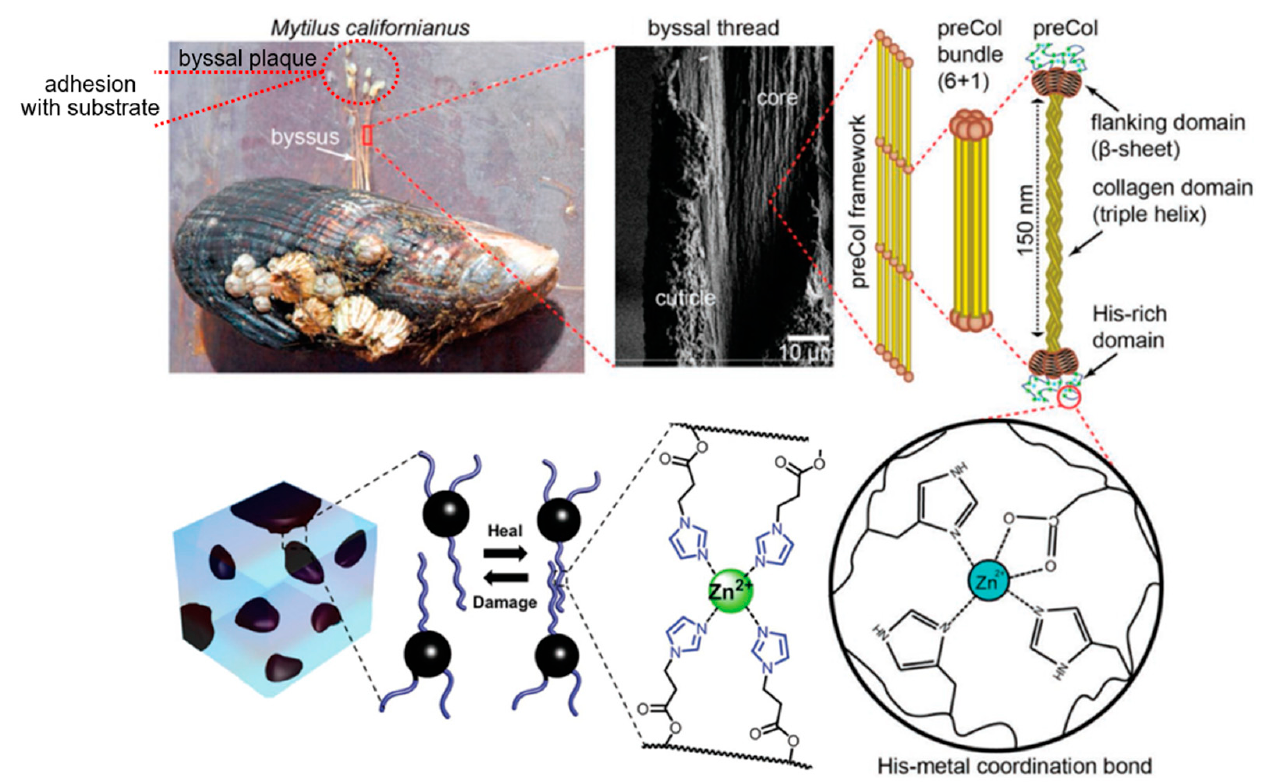
Figure 6. Metal–ligand coordination both in the mussel and between mussel foot protein and substrate [82]. Adapted from [82], with permission from John Wiley and Sons.